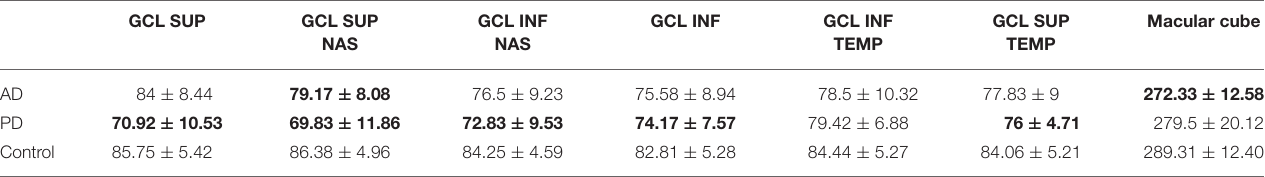
TABLE 3 | GCL average and standard deviation for each sector (superior, superiornasal, inferiornasal, inferior, superiortemporal).